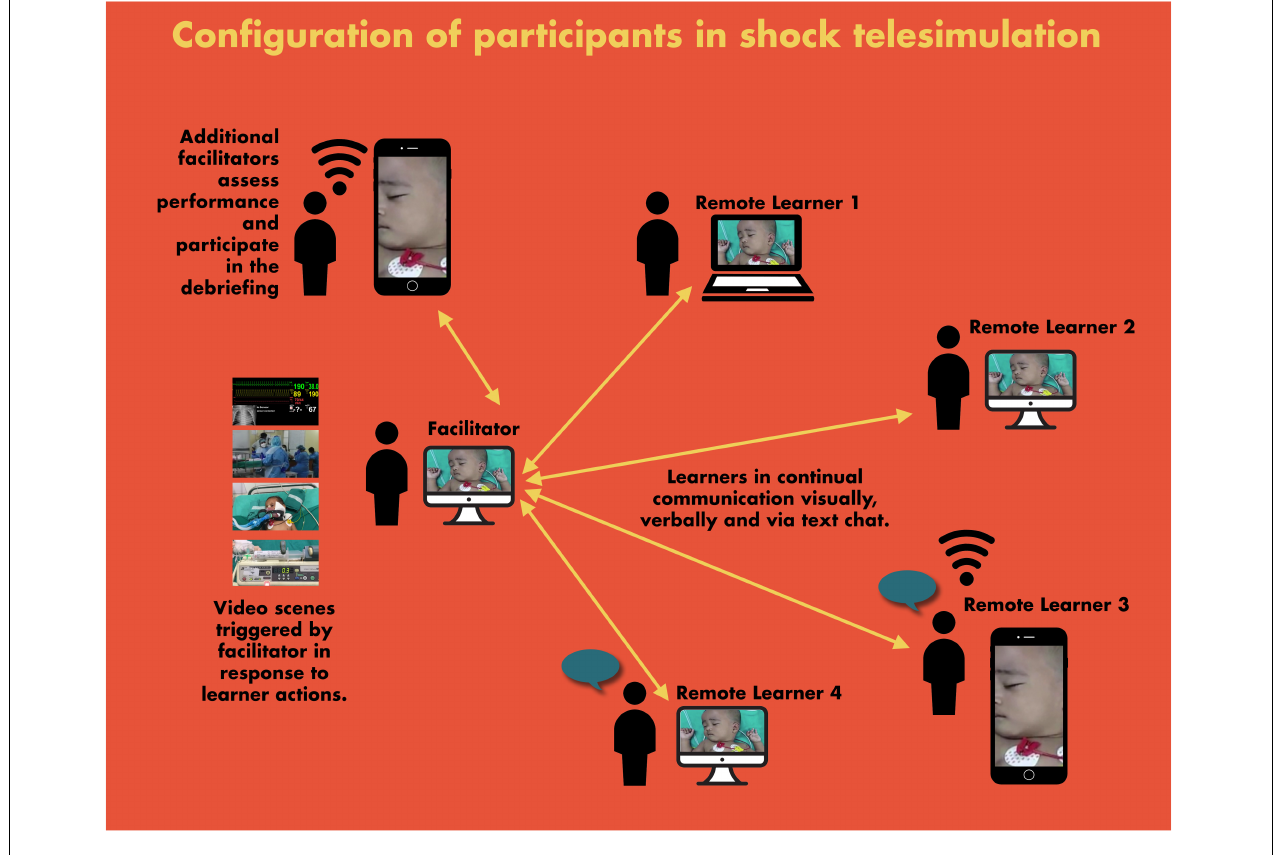
FIGURE 1 | The scheme of telesimulation